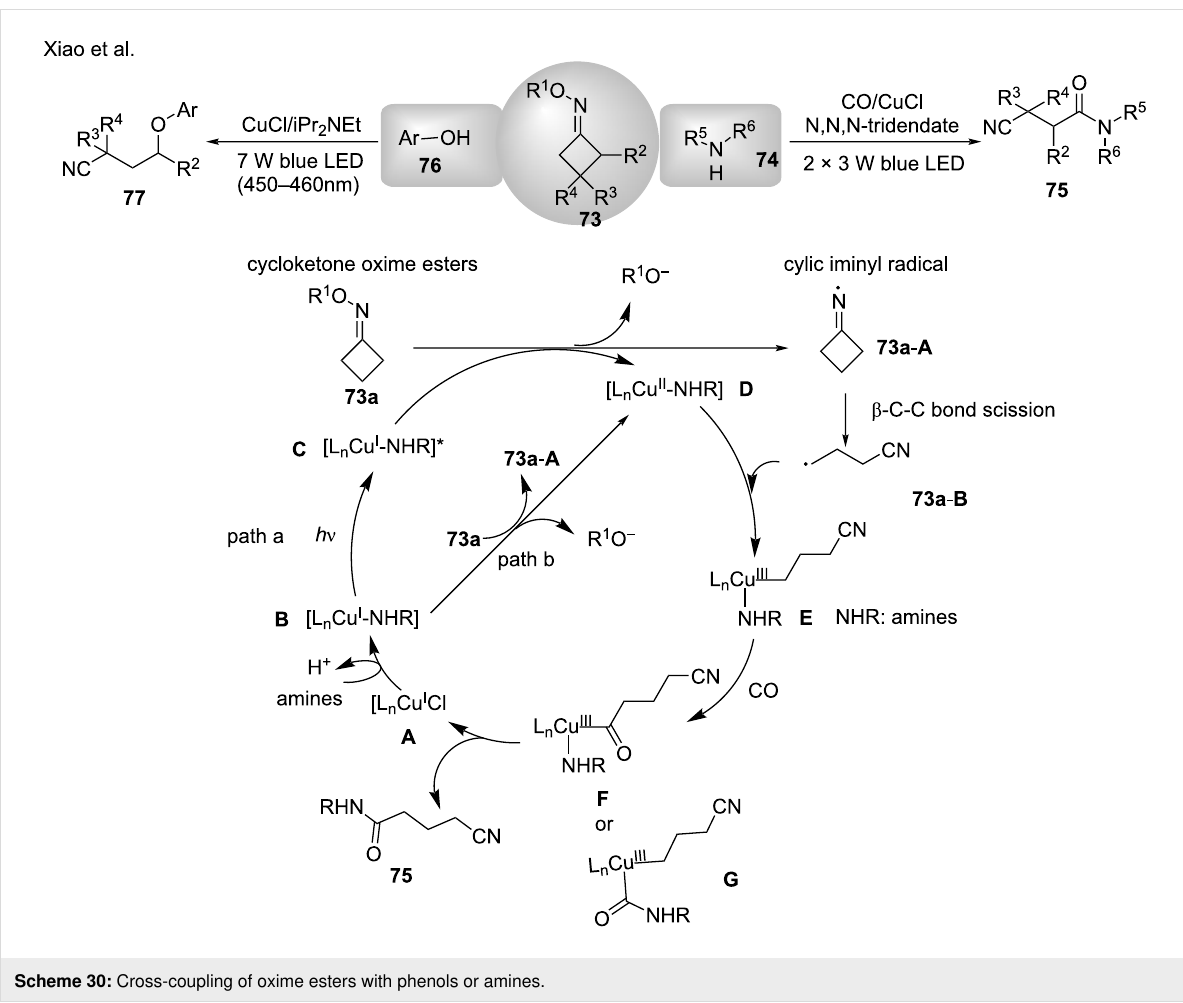
Scheme 30: Cross-coupling of oxime esters with phenols or amines.